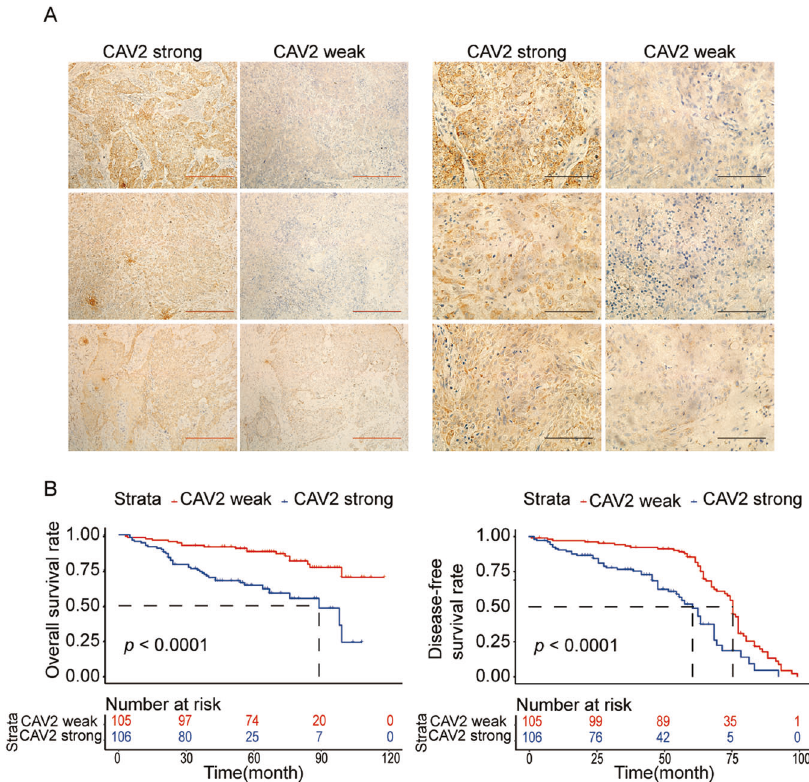
Fig. 1 High expression of CAV2 is associated with the poor prognosis of HNSCC patients. A IHC analysis of CAV2 levels in 211 human HNSCC samples (scale bar, 100 μ m or 400 μ m). B Kaplan – Meier survival curve showing the correlation of overall survival and disease-free survival with the CAV2 IHC